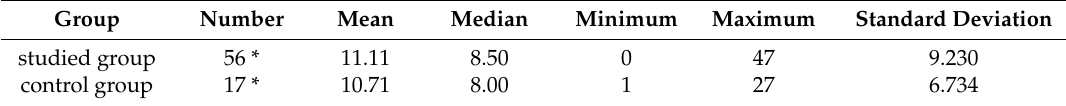
Table 2. Descriptive statistics for the Beck’s Depression Inventory divided into study and control groups.